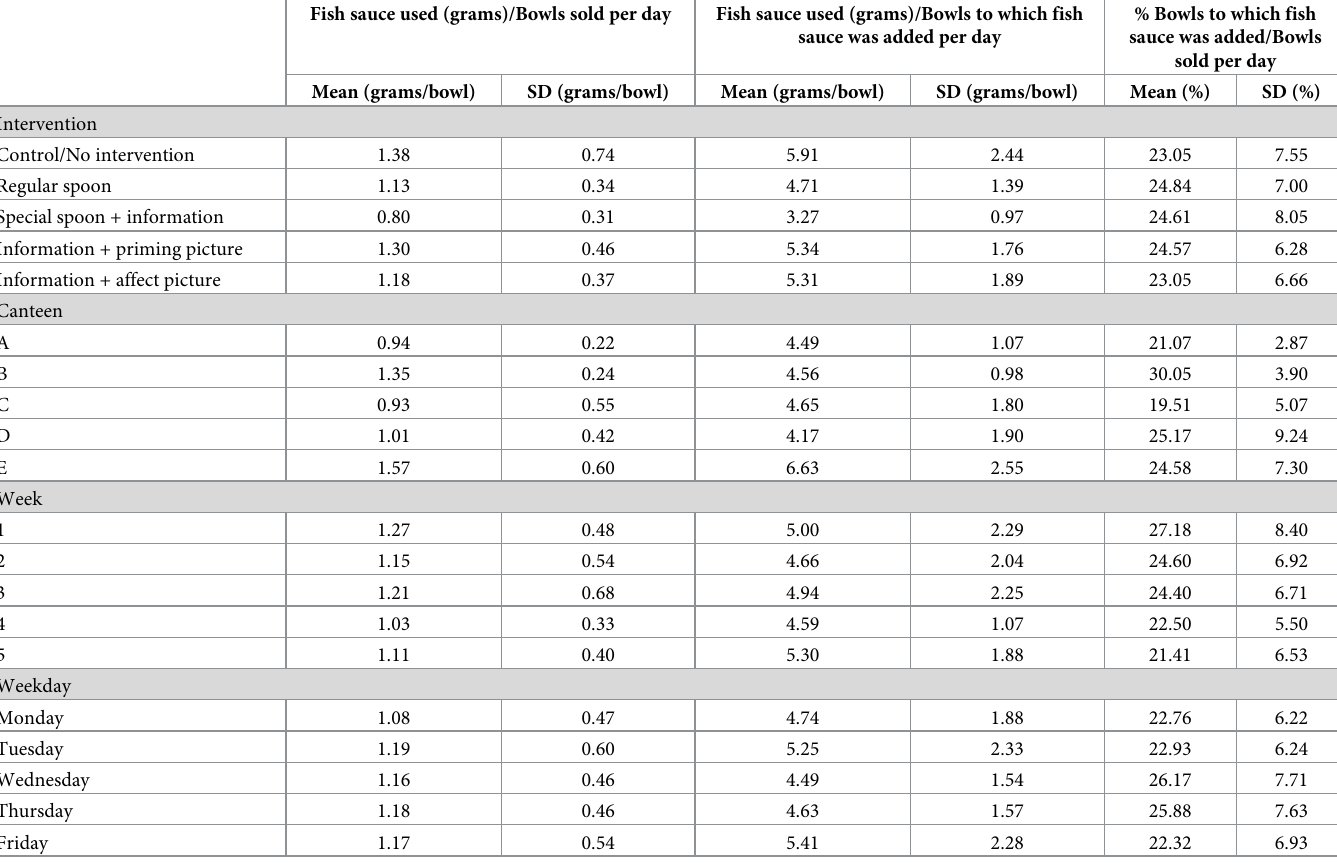
Table 2. Descriptive statistics for the outcomes across interventions, canteens, and week (for the primary analysis) or weekday (for the secondary analysis). Fish sauce used (grams)/Bowls sold per day Fish sauce used (grams)/Bowls to which fish